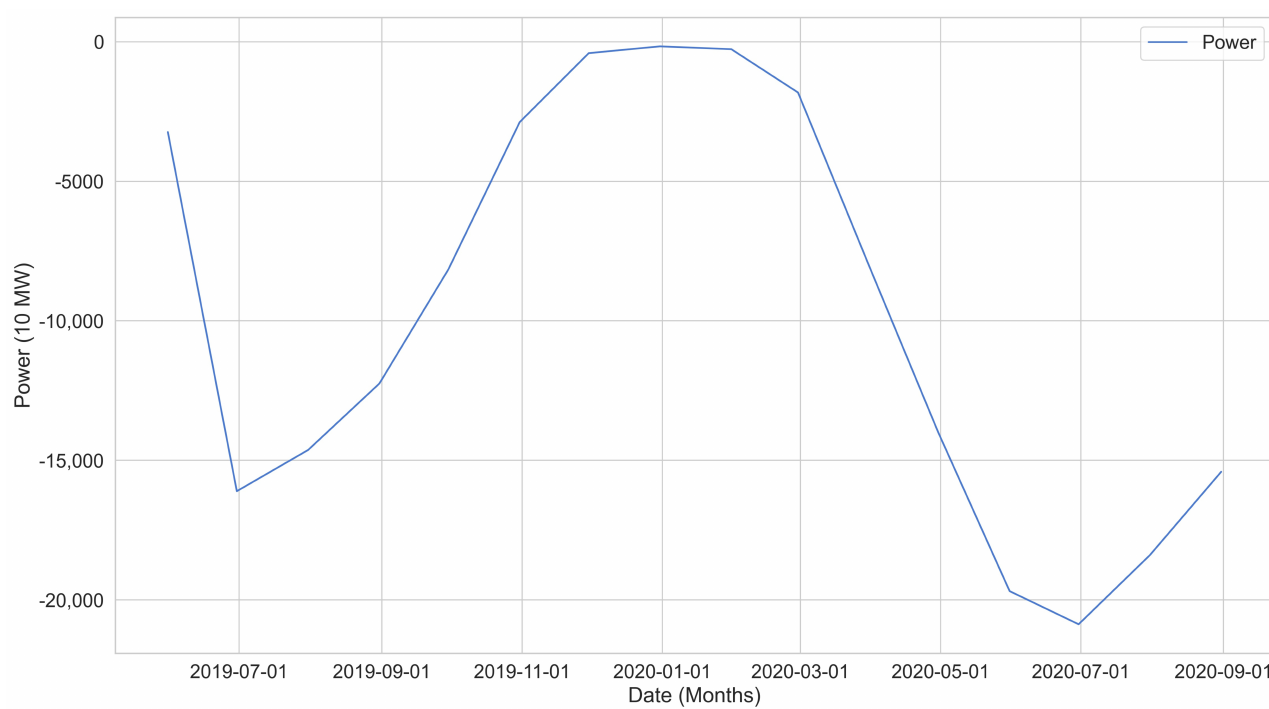
Figure 8. Monthly power output from Photovoltaic